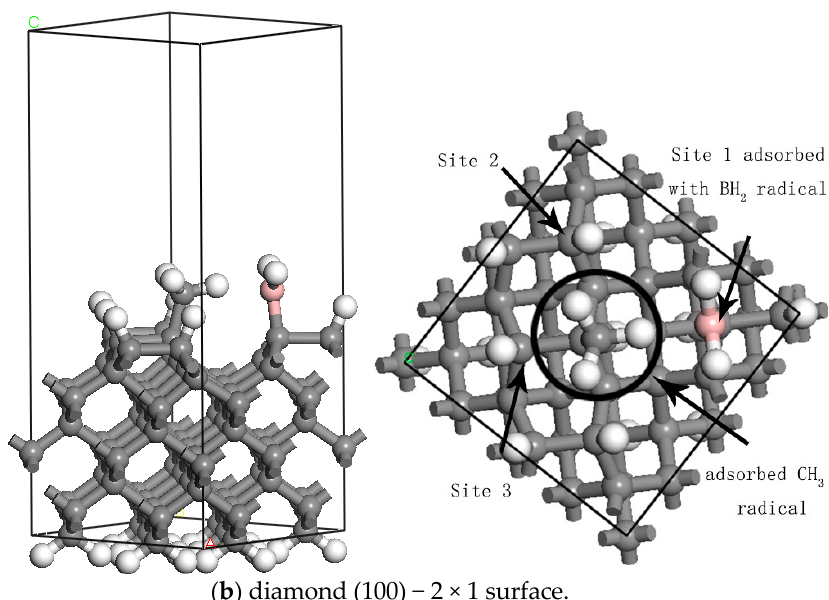
Figure 2. The calculation model which illustrate the relative position between the adsorption sites of the doped species and the radical site for CH 3 adsorption.